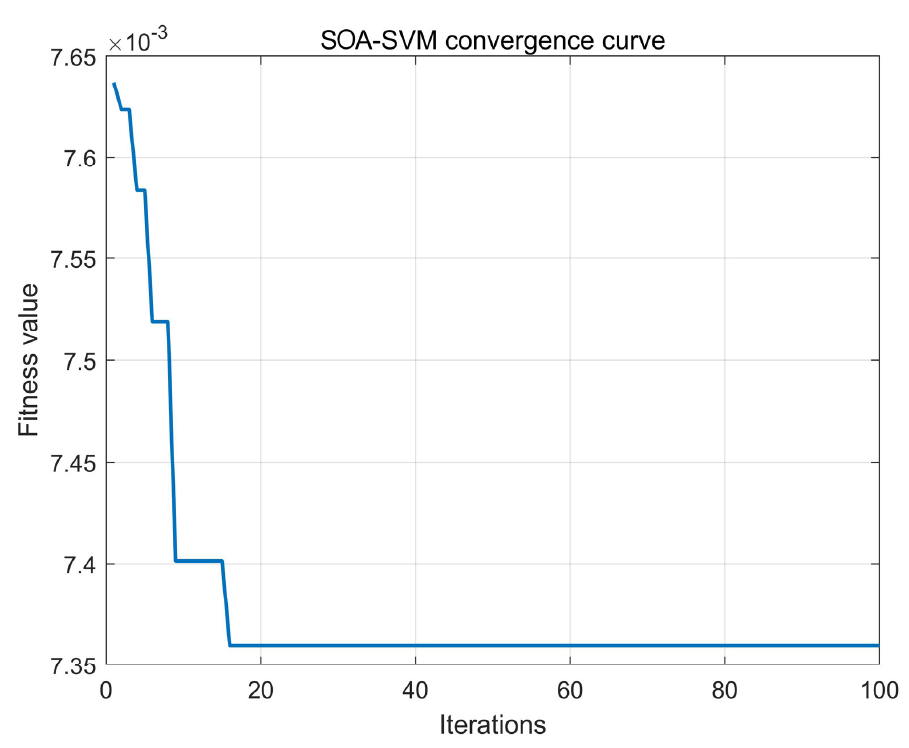
Figure 8. The convergence curve of the test